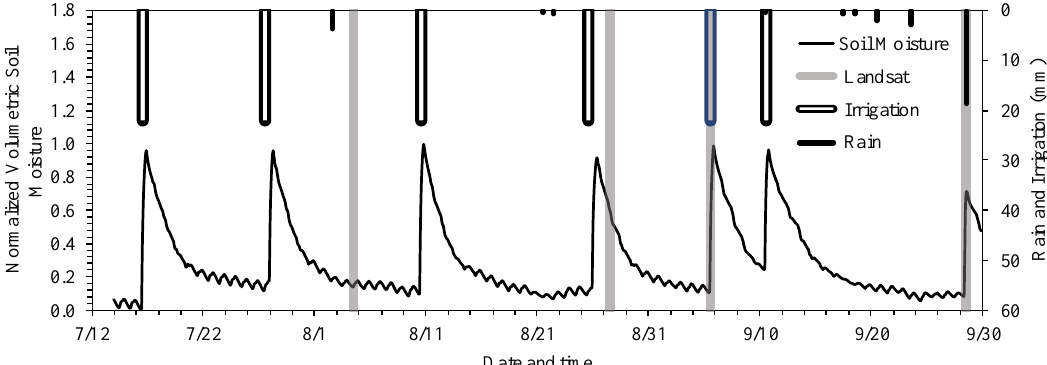
Figure A3. A description of relative soil moisture content, rain, and irrigation time series Field 7, along with Landsat overpass dates.